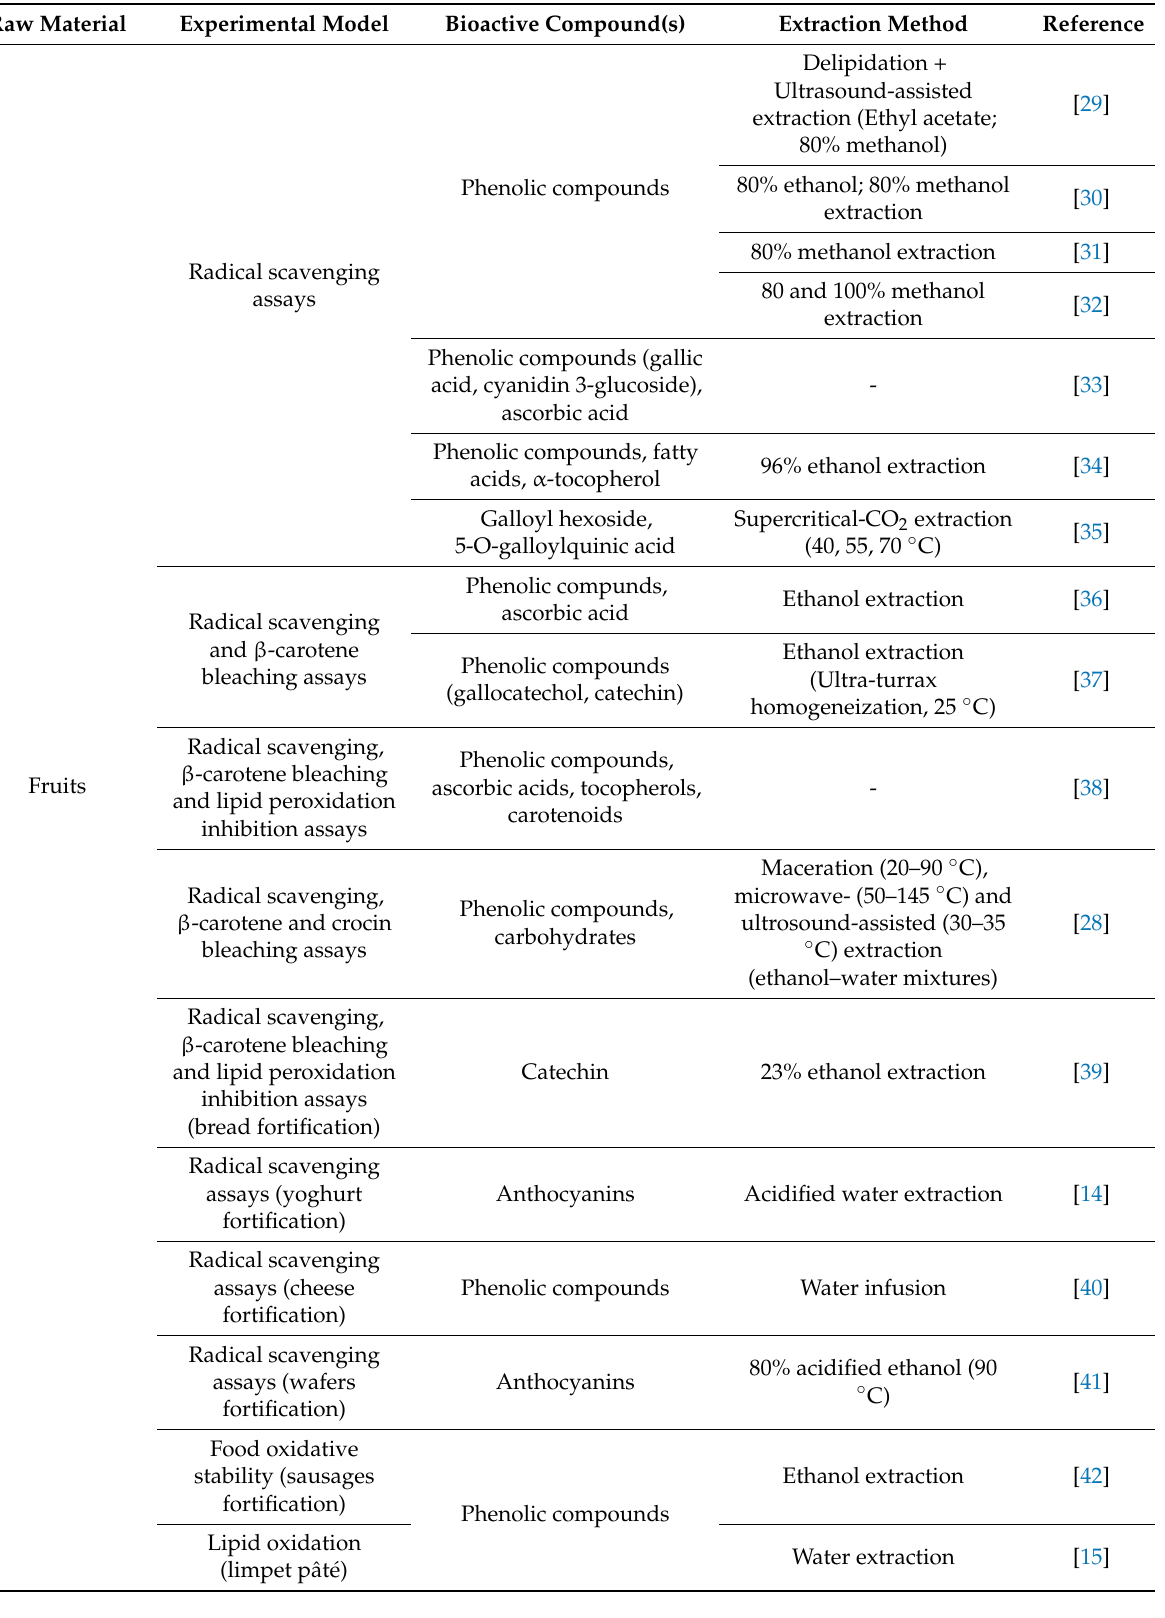
Table 3. Biological activities of Arbutus unedo extracts tested in different experimental